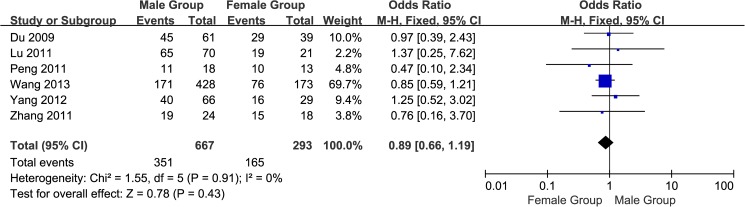
Meta-analysis of overexpression of EpCAM in male group and female group.